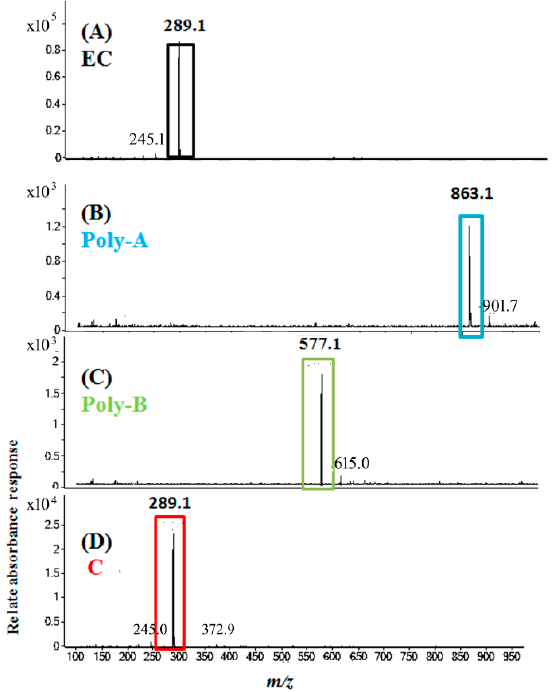
Figure 7. Electron ionization mass spectra of EC and the photoreaction products from ECPB, illuminated by blue light for 2 h. Product ion spectra of [M–H] − for a blue-light-treated ECPB at pH 8.0. The precursor ion selected is m/z 289.1 and the proposed fragments are shown.